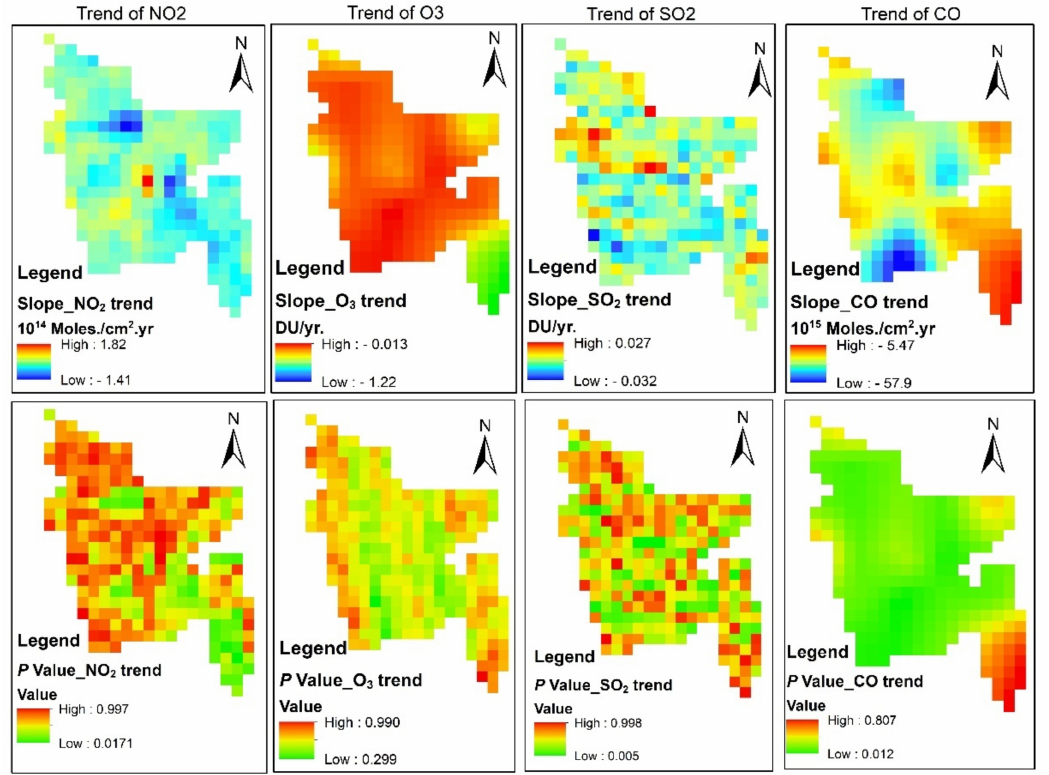
Figure 5. Trend analysis of four air pollutants over Bangladesh (the first row of each column shows the slope, and the second row of each column shows the p